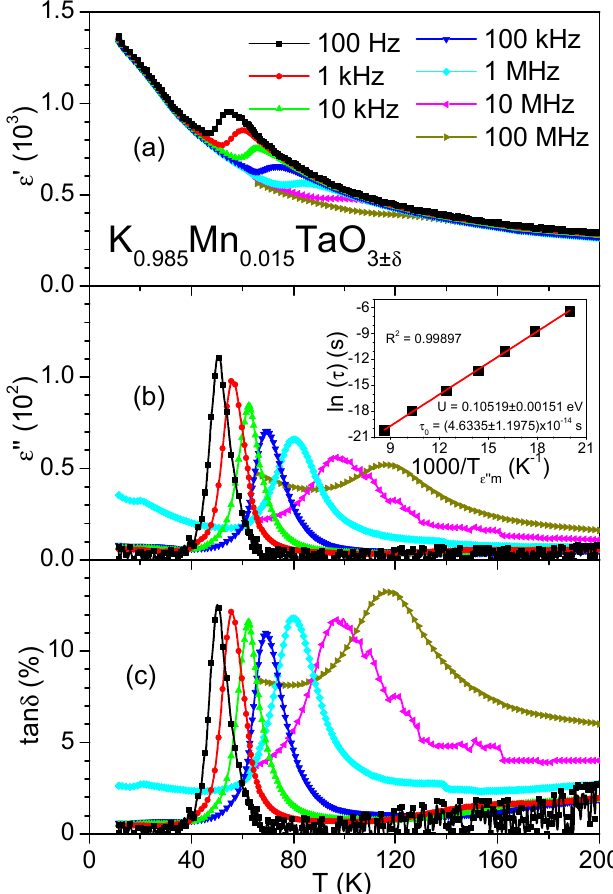
Figure 1. Real ε ′ ( a ) and imaginary ε ″ ( b ) parts of the dielectric permittivity and dissipation factor Figure 1. Real ε (cid:48) ( a ) and imaginary ε ” ( b ) parts of the dielectric permittivity and dissipation factor tan δ ( c ) of K 0.985 Mn 0.015 TaO 3± δ ceramics as a function of temperature T in the 100 Hz–100 MHz fre- tan δ ( c ) of K 0.985 Mn 0.015 TaO 3 ± δ ceramics as a function of temperature T in the 100 Hz–100 MHz quency range. Inset shows the Arrhenius plot ln( τ ) versus 1000 /T ε ″ m for the dielectric relaxation of frequency range. Inset shows the Arrhenius plot ln( τ ) versus 1000 /T ε ”m for the dielectric relaxation K 0.985 Mn 0.015 TaO 3± δ ceramics with fits to the Arrhenius law (solid line) and the fit parameters. of K 0.985 Mn 0.015 TaO 3 ± δ ceramics with fits to the Arrhenius law (solid line) and the fit